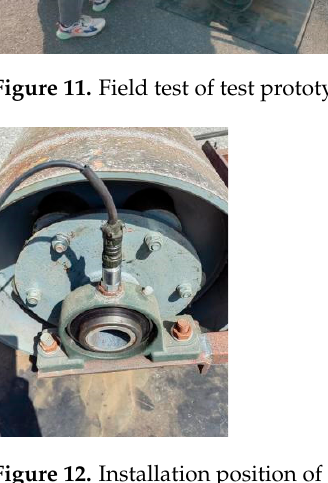
Figure 12. Installation position of acceleration sensor of vibrating drum.